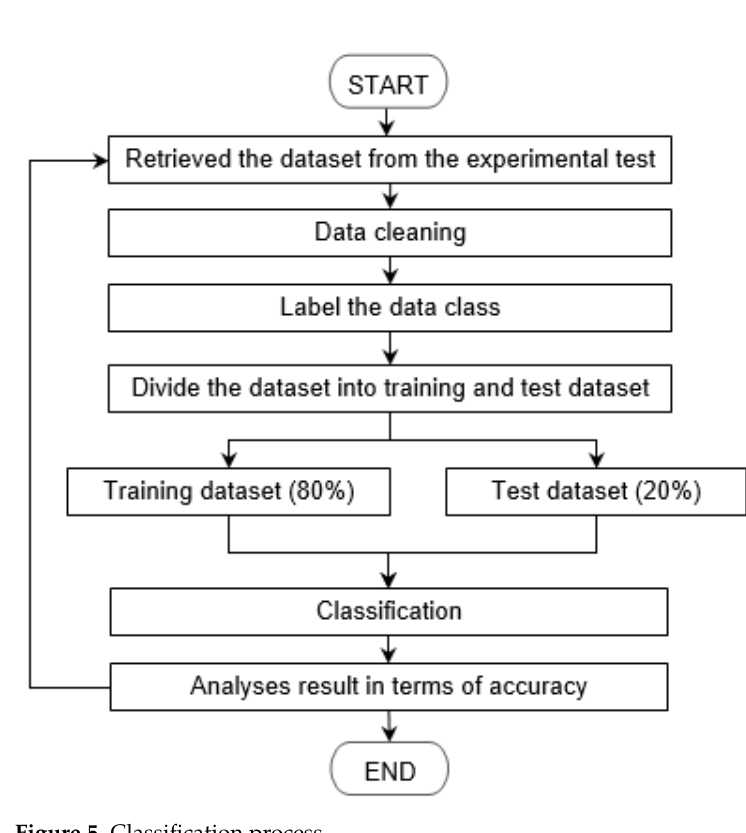
Figure 5. Classification process.